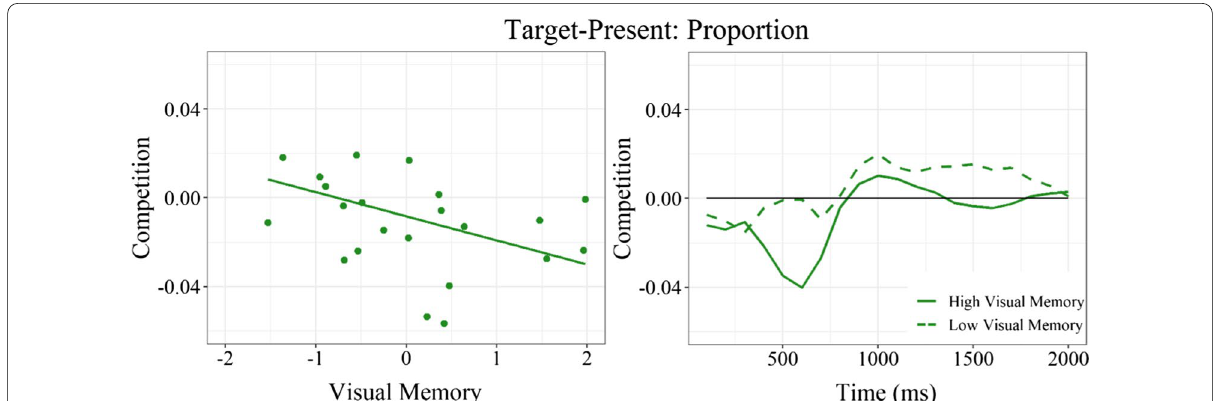
Fig. 5 Relative proportion of competitor fixations (competitor—control) by z -scored visual memory (left) and over time for children with high (solid) and low (dashed) visual memory (right). Lower visual memory was associated with significantly greater phonological competition. Positive values indicate more looks to competitor than control objects